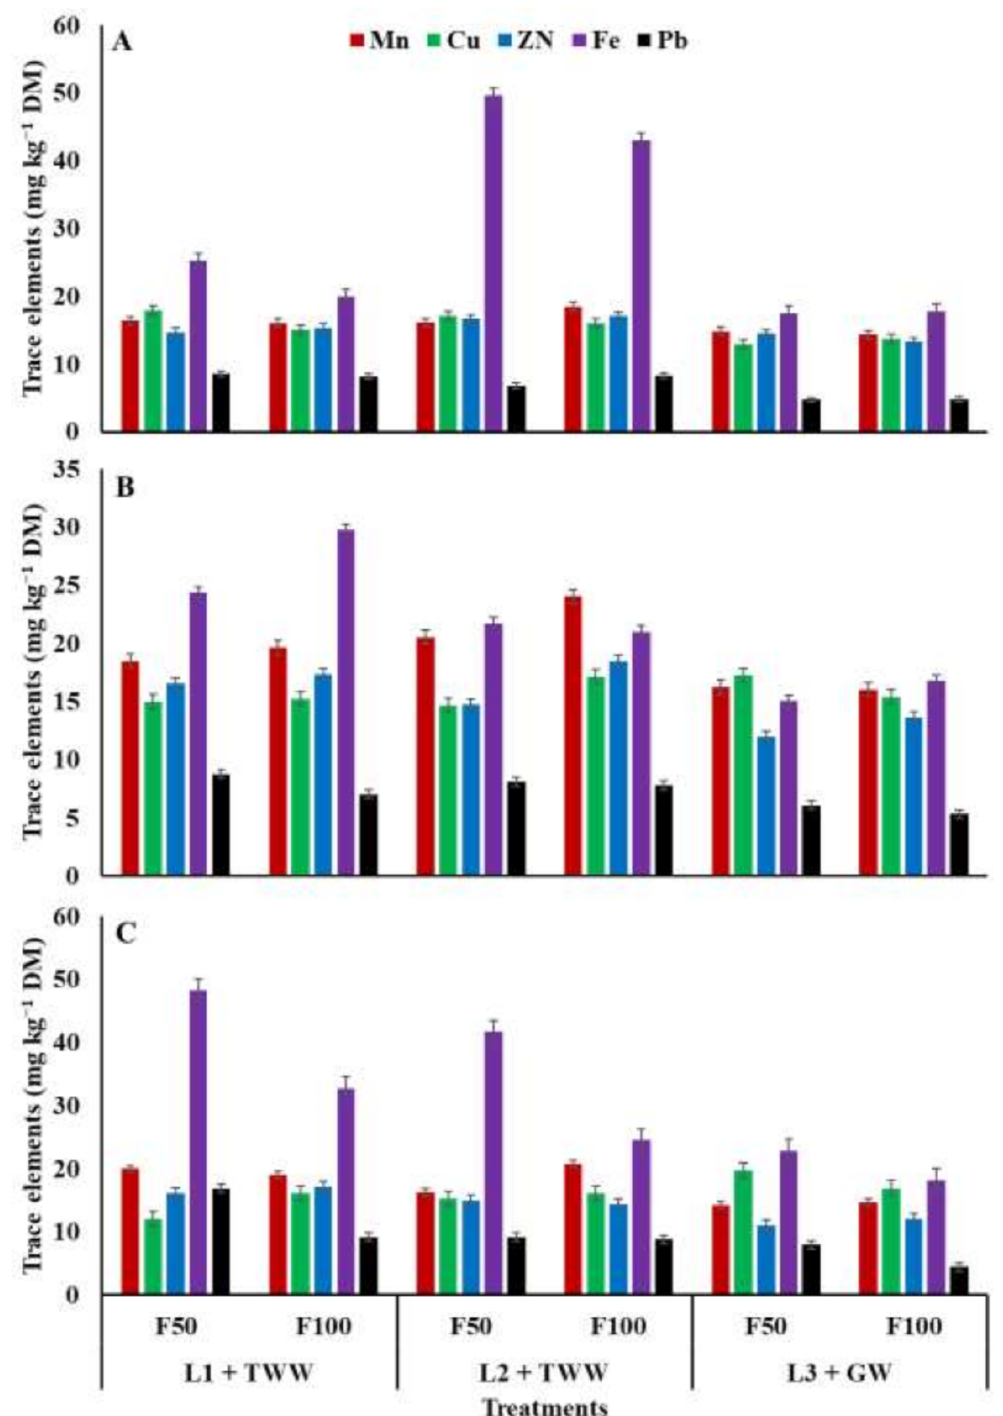
Figure 2. Interaction effects of water resources and fertilization treatments on five trace elements in maize ( A ), sorghum ( B ) and pearl millet ( C ). Error bars = Standard error of means (S.E.M.). L1 + TWW = Old soil + Wastewater; L2 + TWW = Virgin soil + Wastewater; L3 + GW = Virgin soil + Groundwater; F50 and F100 are 50% and 100% NPK of the total recommended dose,